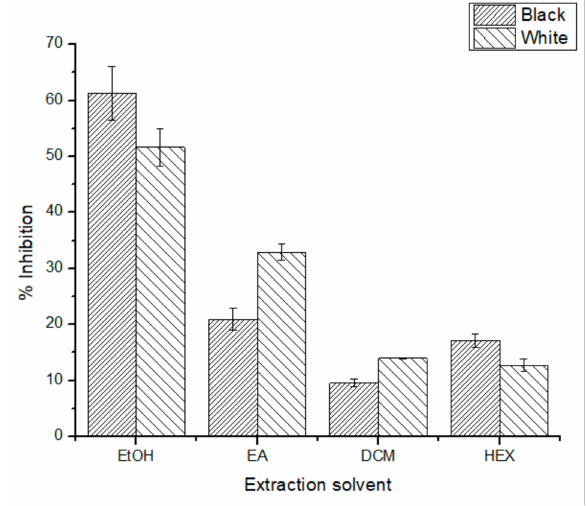
Figure 3. %Inhibition for all extracts tested. All differences were statically significant ( p < 0.05).